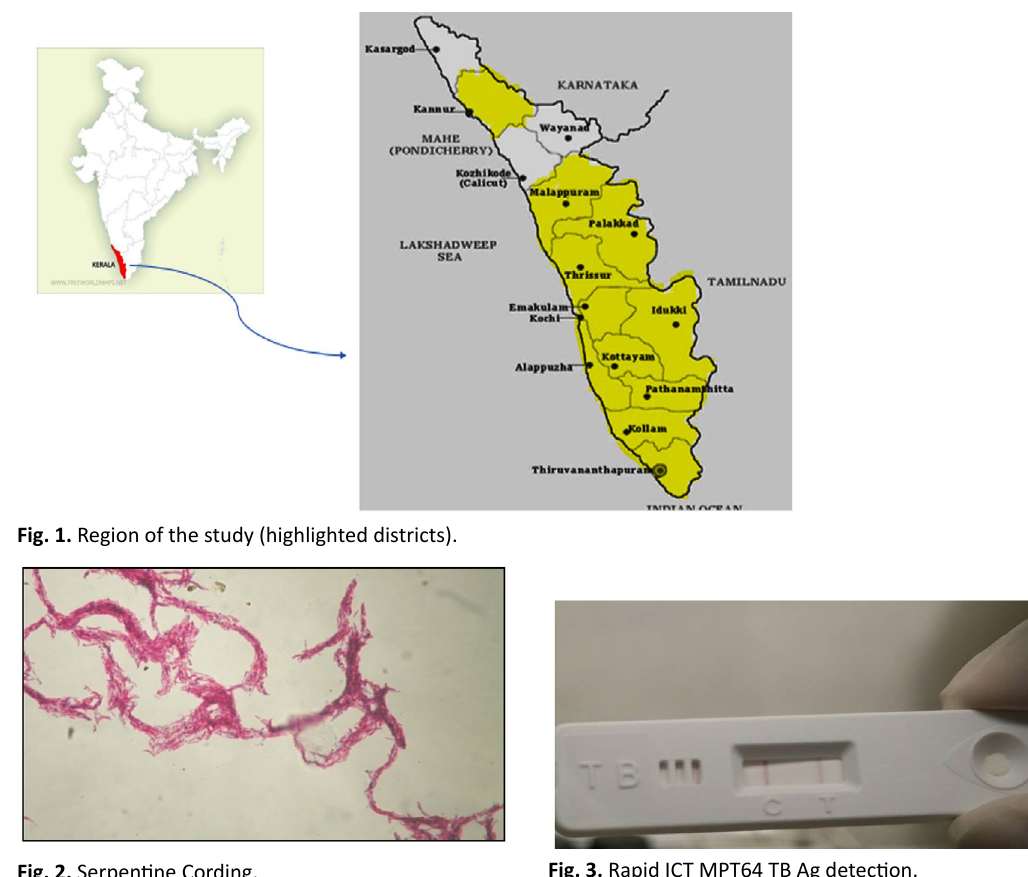
Fig. 2. Serpentine Cording. Fig. 3. Rapid ICT MPT64 TB Ag